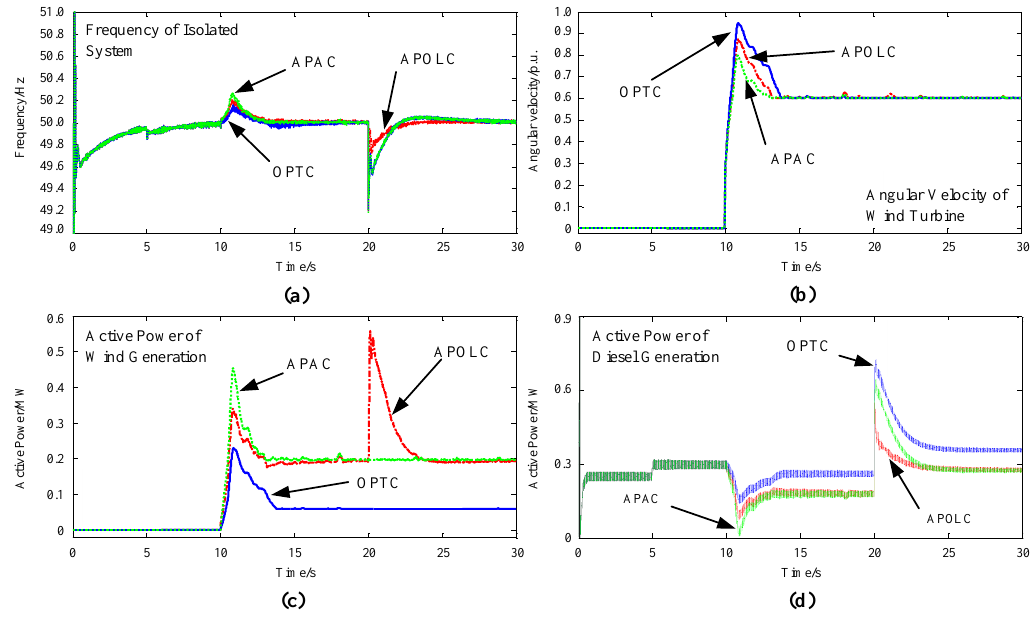
Figure 6. Simulation results of the existing virtual inertia control strategies: ( a ) frequency of the isolated system; ( b ) angular velocity of the wind turbine; ( c ) active power of wind generation; and ( d ) active power of diesel generation.